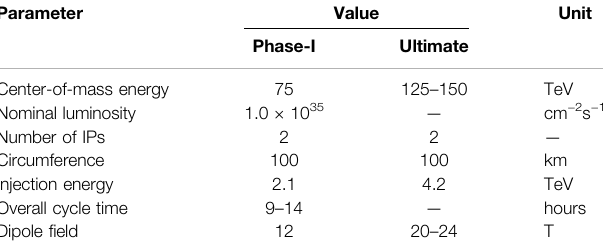
TABLE 1 | Key parameters of the SPPC baseline design.